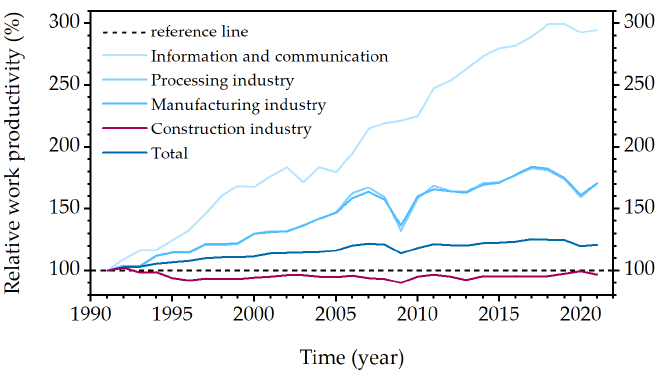
Figure 1. Development of relative work productivity per worker in Germany since 1991 (100%), data taken from [1].